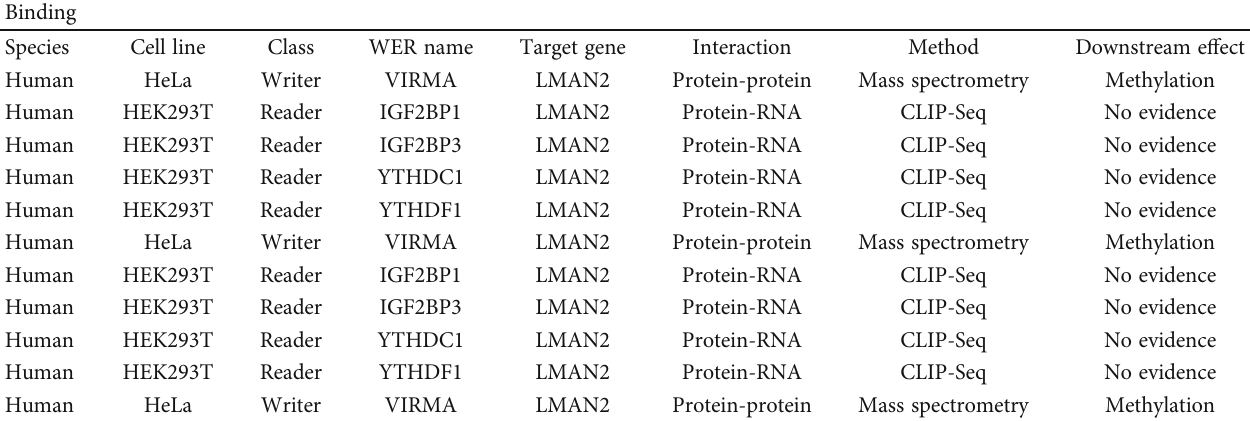
Table 4: The target genes that inferred from CLIP-Seq, RIP-Seq, CHIP-Seq, or mass spectrometry. Binding Species